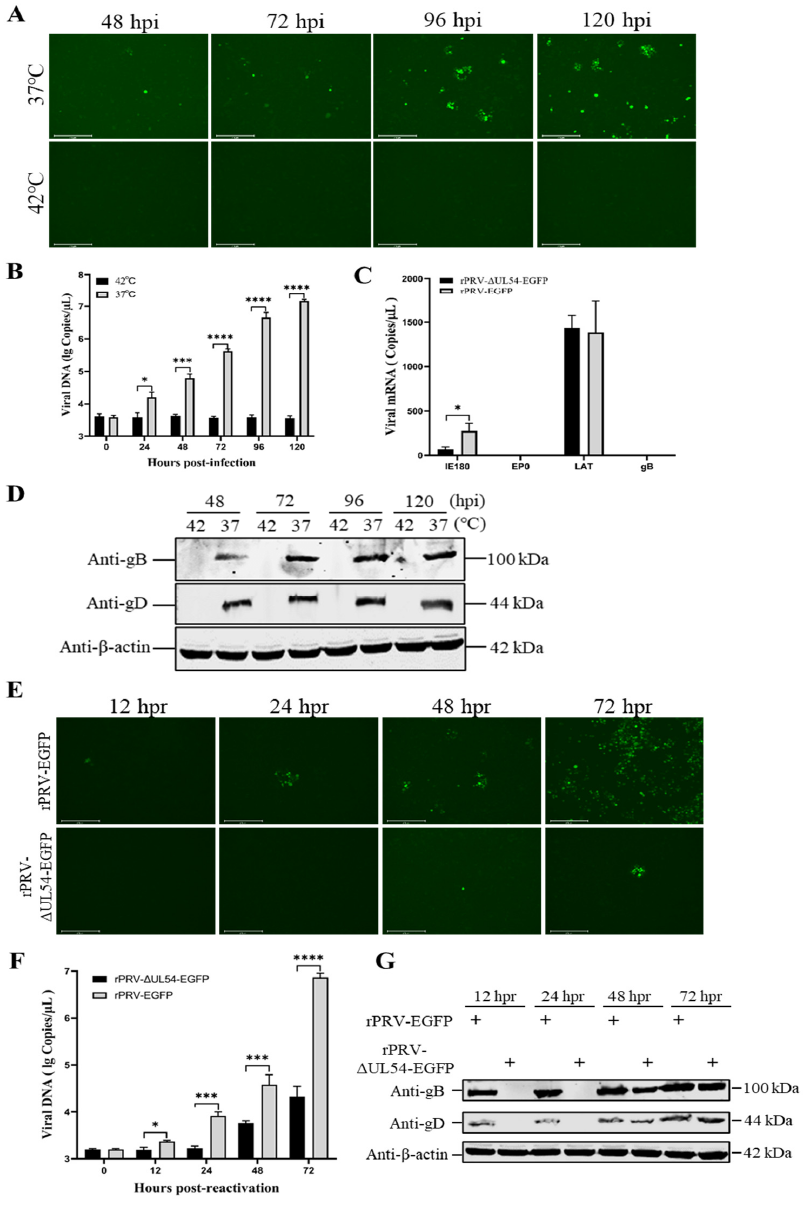
Figure 6. Latent infection and reactivation of rPRV- Δ UL54-EGFP. Based on the established model, rPRV- Δ UL54-EGFP was tested. ( A ) Identification of the effect of UL54 deletion on latent infection. ( B ) Latent and lytic viral DNA copy detection. N2a cells were infected with rPRV- Δ UL54-EGFP at an MOI of 0.01 and were incubated at 37 °C for 2 h. After rPRV- Δ UL54-EGFP was cultured at 42 °C for 120 h, the samples were then collected, and viral DNA was extracted; additionally, the gB gene was detected through real-time PCR to quantify genomic DNA. ( C ) Quantification of the tran- scripts of the latency-associated viral genes. After rPRV- Δ UL54-EGFP was cultured at 42 °C for 120 h, the samples were then collected, and total RNA was extracted; additionally, the mRNA of the IE180 , EP0 , LAT , and gB genes was detected through RT-qPCR. ( D ) Inability of latent rPRV-UL54-EGFP to express lytic viral proteins. ( E ) Fluorescence spots of rPRV-EGFP and rPRV- Δ UL54-EGFP during reactivation. N2a cells were infected with rPRV-EGFP and rPRV- Δ UL54-EGFP (MOI = 0.01), were incubated at 42 °C for 120 h, and were then transferred to 37 °C for culture. EGFP fluorescence was monitored at 12, 24, 48, and 72 h postreactivation (hpr). ( F )